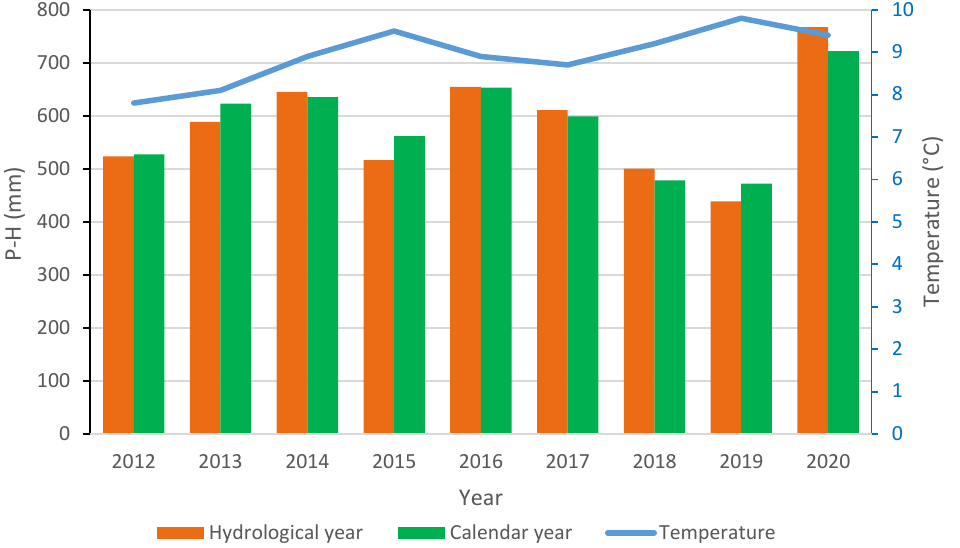
Figure 4. Simplified water balance of the Świerszcz River catchment area in 2012–2020 (P—rainfall, H—outflow).